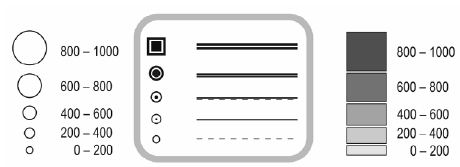
Fig. 3. Graphical similarity of “quantitative signature symbols” to graduated diagrams and choropleth method (own elaboration)